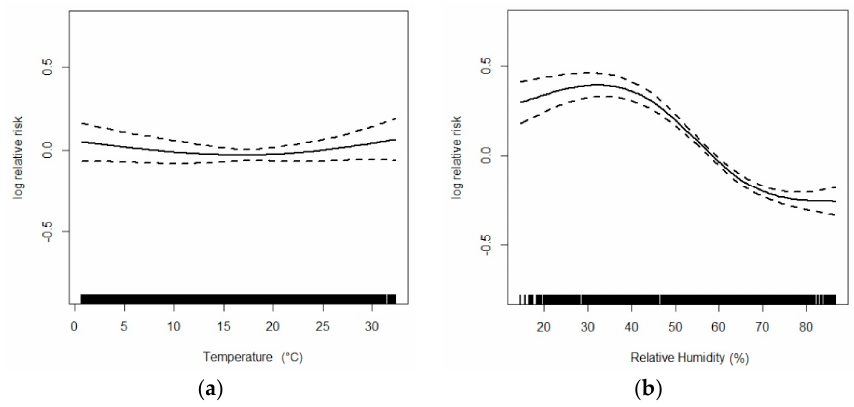
Figure 2. Exposure-response curves for the associations of mean temperature ( a ) and relative humidity ( b ) with outpatient visits for eczema (lag 06).